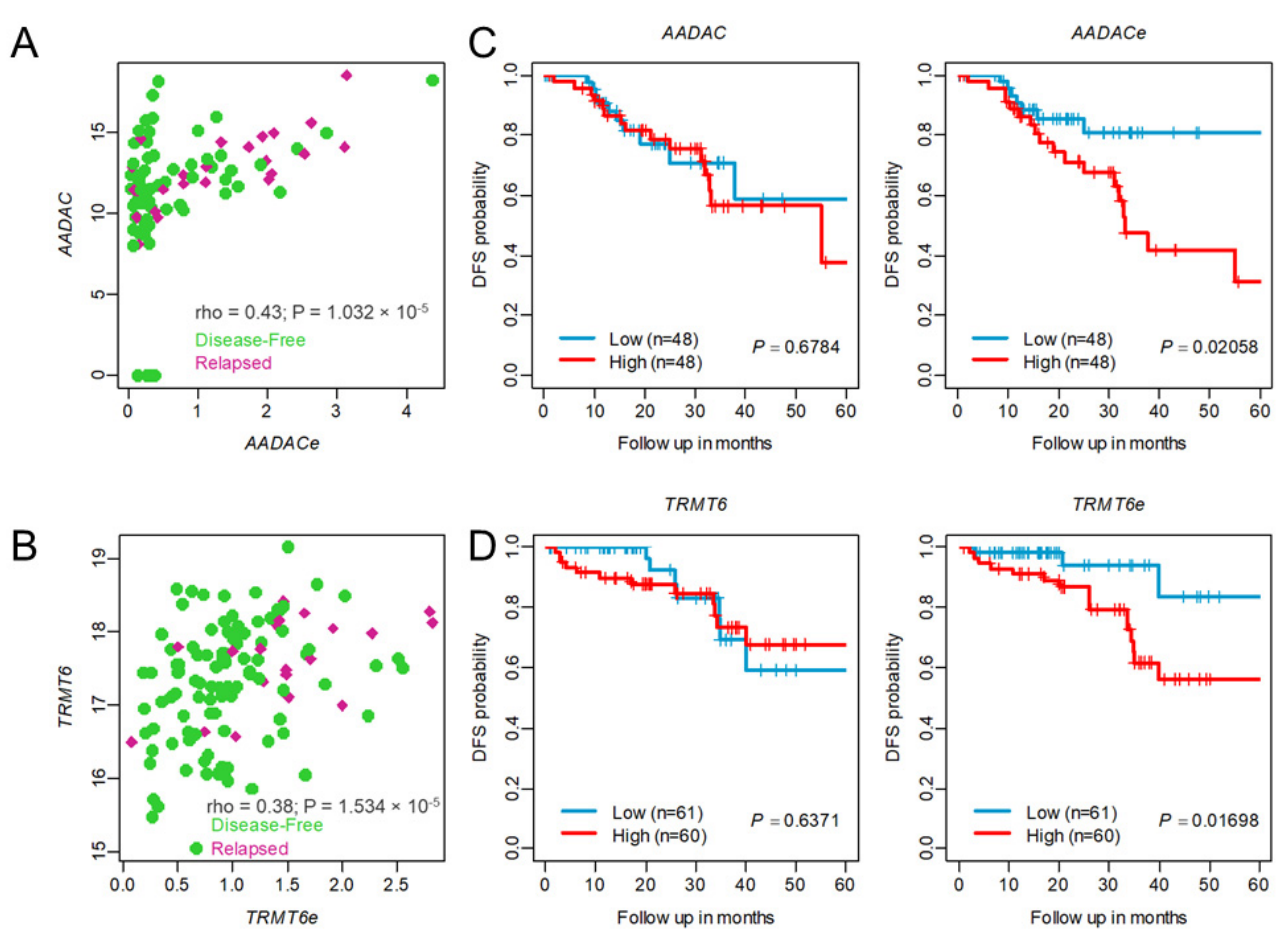
Figure 6. Association between enhancer RNA and their neighbor protein-coding target genes. Spearman correlation coefficient (SCC) analysis shows a positive correlation between enhancer RNA and neighbor protein-coding genes from the ( A ) colon cancer CMS4 subtype cohort and ( B ) rectal cancer cohort. Dots in green represent disease-free patients, and red represents patients with relapsed tumors. ( C , D ) Kaplan–Meier plots show enhancer RNA higher expression is associated with tumor relapsed than its neighbor target genes in the colon cancer CMS4 subtype cohort and rectal cancer cohort. rho = spearman correlation